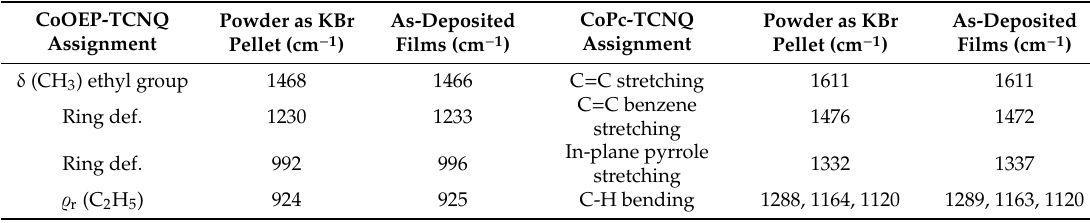
Figure 6. FTIR spectra of the ( a ) CoOEP-TCNQ and ( b ) CoPc-TCNQ films and their precursors. Table 1. FTIR band positions and assignments of CoOEP-TCNQ and CoPc-TCNQ as obtained (powders) and as thin films.